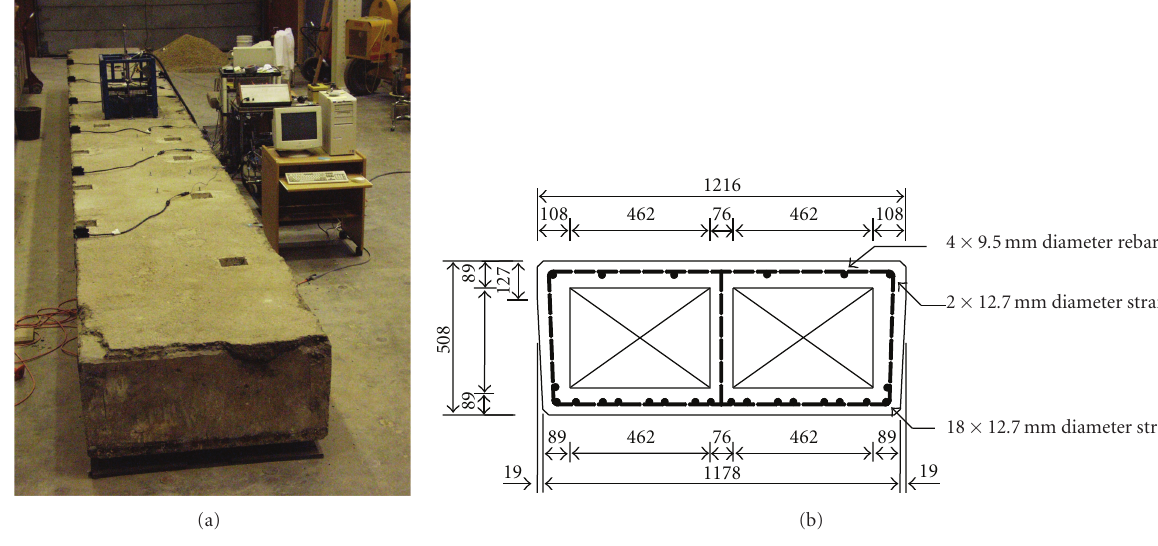
Figure 2: The prestressed concrete box girder used for the experimental study: (a) photograph of the girder set up for testing in the laboratory, and (b) transverse cross section (dimensions in mm).